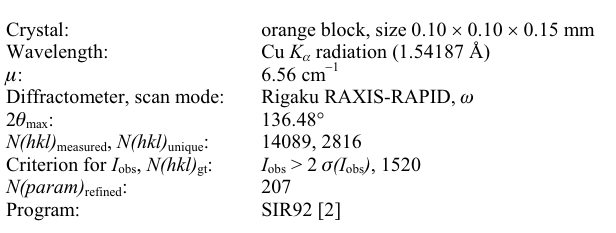
Table 1. Data collection and handling.